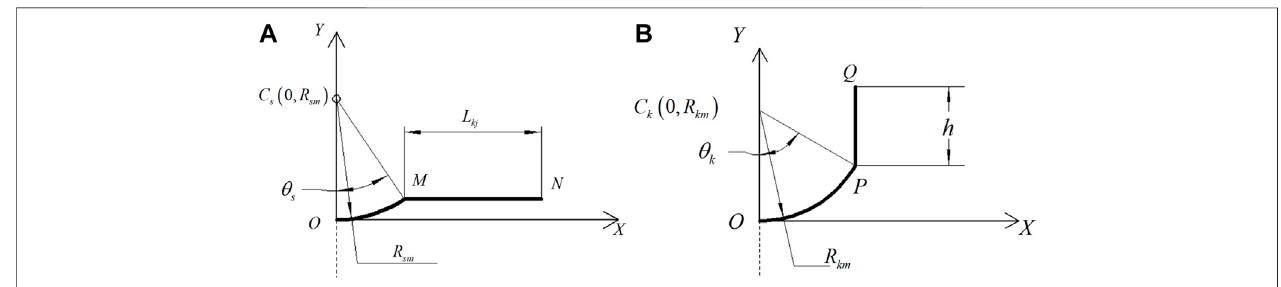
FIGURE 5 | (A) The generatrix of deformation zone in a contraction segment. (B) The generatrix of deformation zone in an expanding segment.